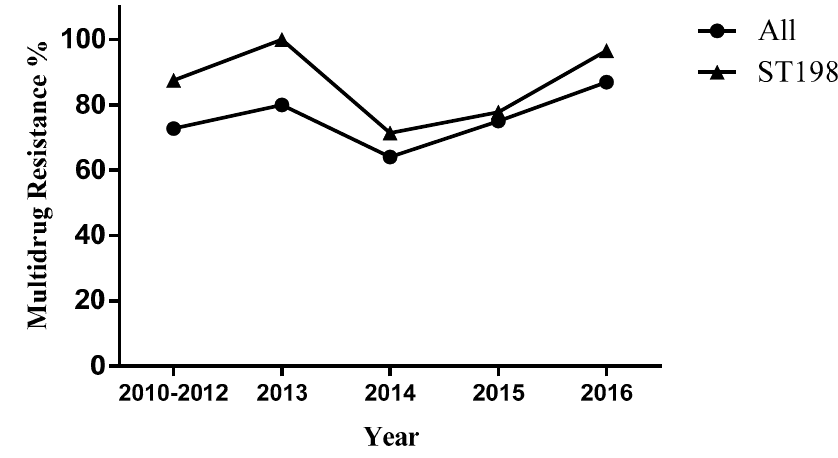
Figure 2. Multidrug resistance of Salmonella enterica serovars Kentucky, China, 2010–2016.